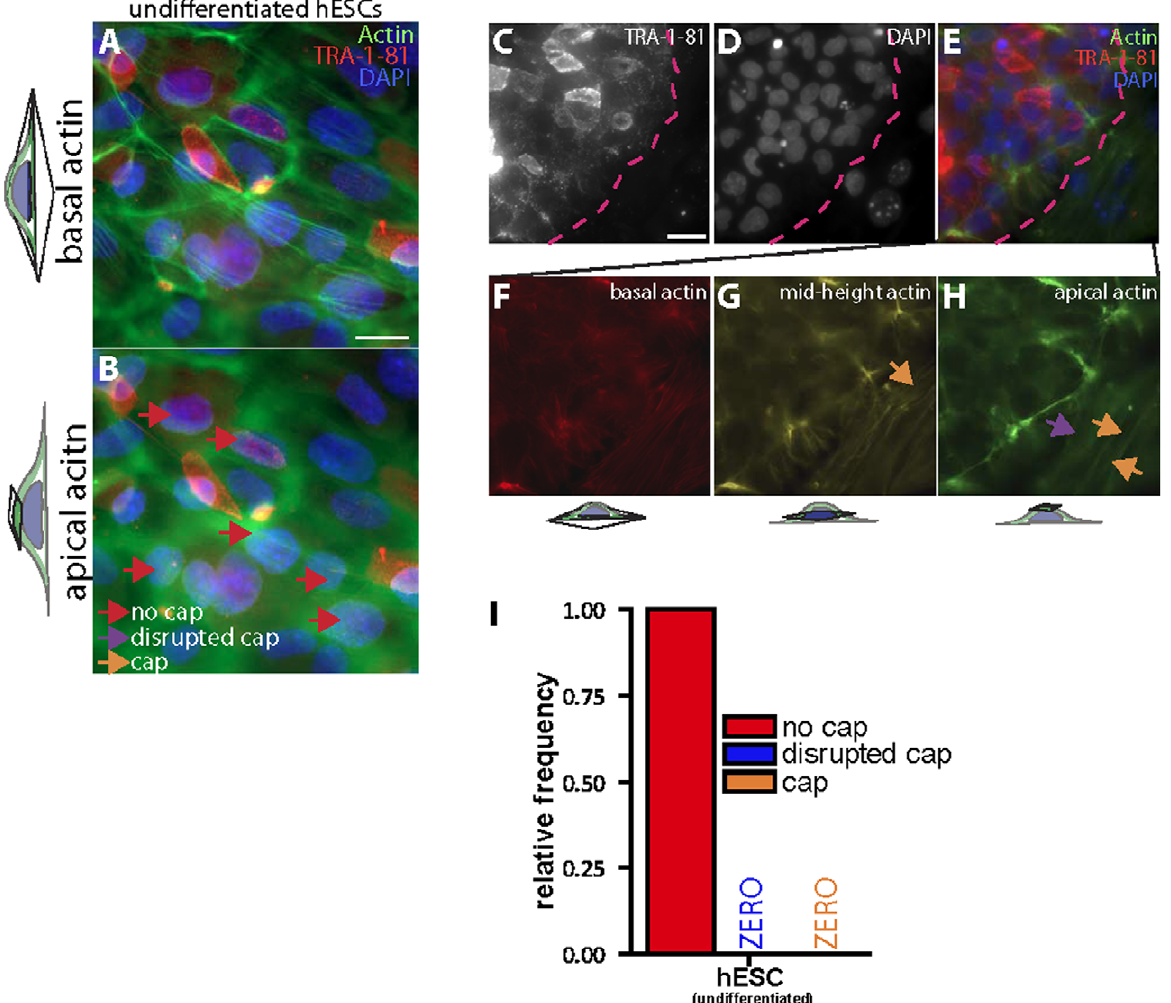
Figure 2. The perinuclear actin cap is absent in undifferentiated human embryonic stem cells (hESCs). A and B. Well developed basal stress fibers (A) and absence of apical perinuclear actin cap (B) in undifferentiated hESCs. Red arrows indicate examples of cells showing no actin cap on top of nuclei. Cells were stained for differentiation marker TRA-1-81 (red), nuclear DNA (DAPI, blue), and actin (green). Scale bar, 20 m m. C–H. Basal and apical actin filament organization in a colony of undifferentiated TRA-1-81-positive hESCs (upper left region of panels C–H) and peripheral TRA-1- 81-negative hESCs undergoing differentiation (lower right region of panels C–H). The dashed line delineates the edge of the TRA-1-81-positive hESC colony from TRA-1-81-negative hESCs that have started to undergo differentiation and start forming actin caps. Orange and purple arrows point to organized and disorganized/disrupted actin cap, respectively. Scale bar, 100 m m. I. Fractions of TRA-1-81-positive hESCs showing no actin cap (red bar), a disorganized/disrupted actin cap (blue bar), and an organized actin cap (orange). At least 100 cells in triplicate for a total of 300 cells were probed per condition.